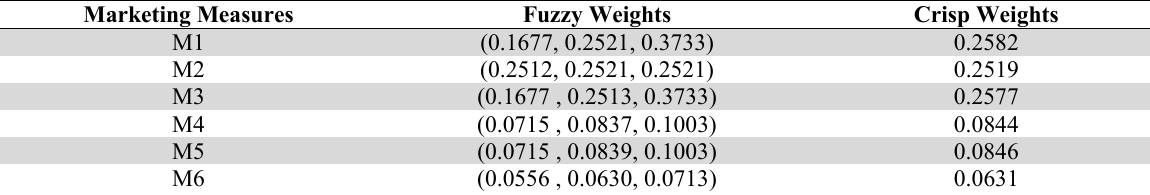
Fuzzy and Crisp Weights of Measures According to FUCOM-F